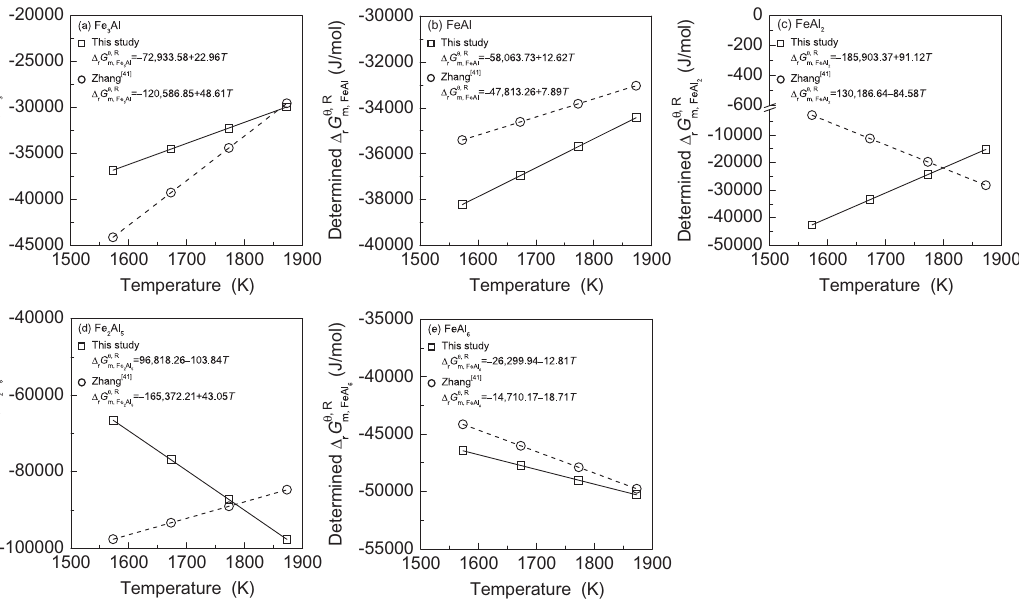
in this study and reported ones by m,c i